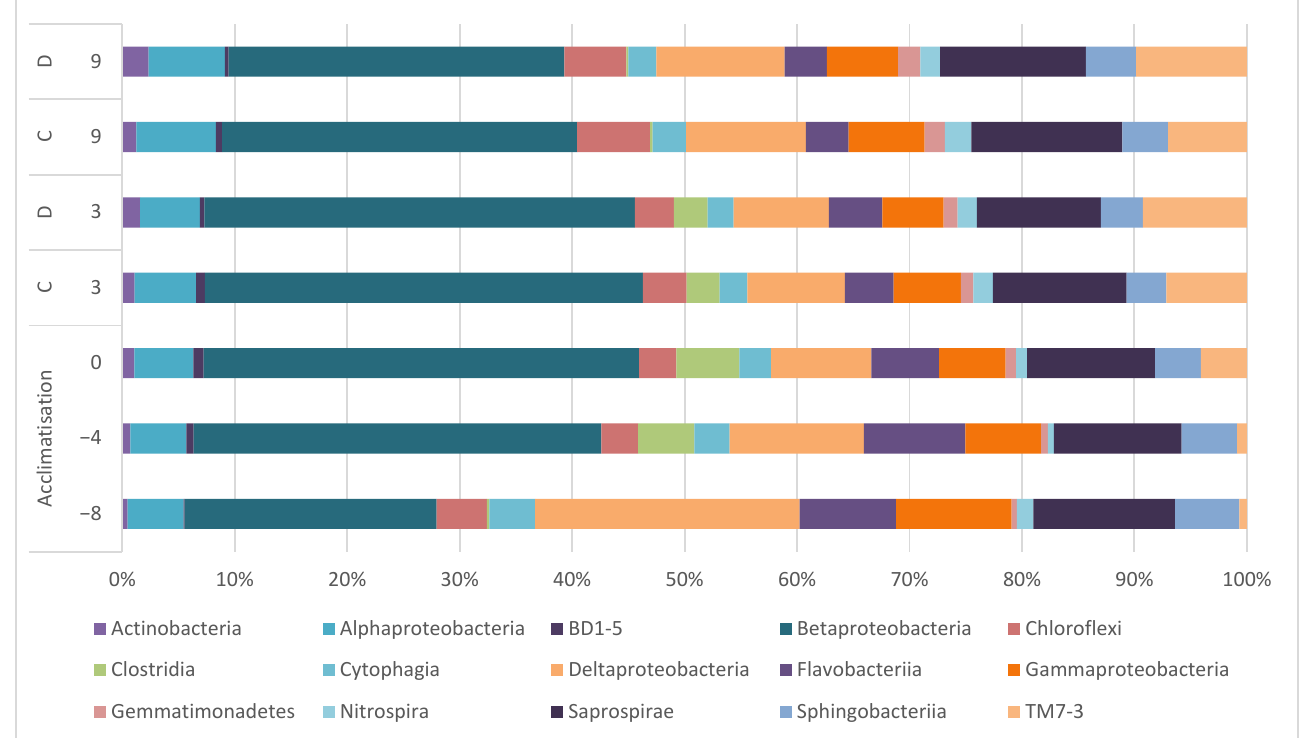
Figure 3. Mean abundances at class level of the sludge community from collection of fresh sludge until day 9 (C = control Table 7. increased their relative abundance over time. No changes in relative abundance were observed for classes such as Saprospirae, Sphingobacteria, or the nitrite oxidizing Nitrospira . For all described classes, no significant difference (Student t -test, p > 0.05) was observed between control and dispersant (evaluated at days 3 and 9). The analysis conducted to genus level (Supplementary Figure S2) confirmed that there are no significant differences (Student t -test, p > 0.05) between control and dispersant.